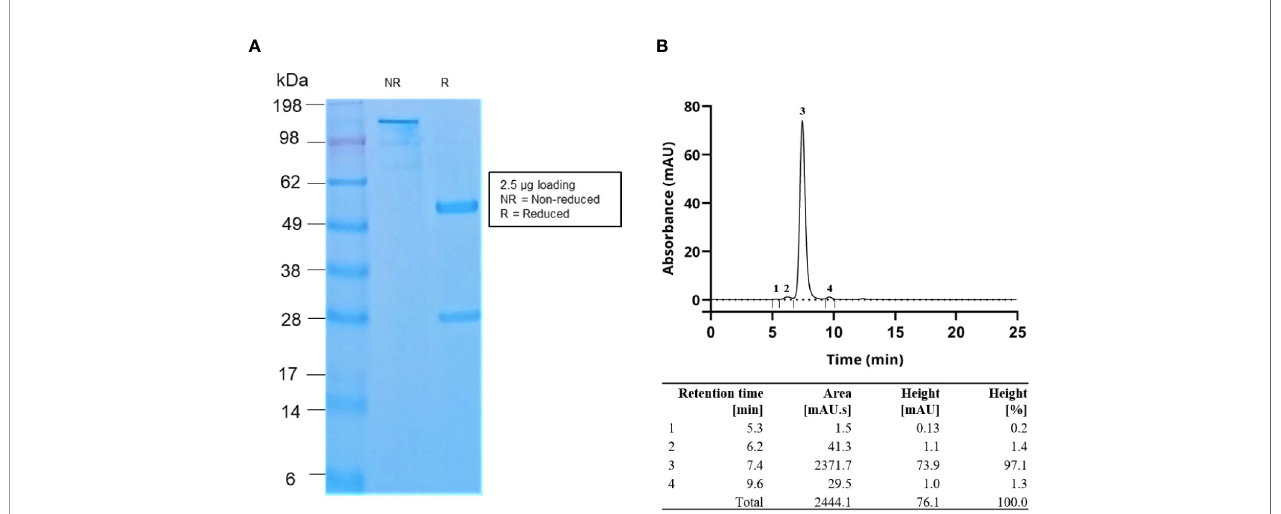
FIGURE 3 | (A) SDS-PAGE gel image and (B) SEC data of the puri fi ed IgG antibodies. The SEC data demonstrated that the antibody purity was >97%. Flow rate in SEC was 0.2